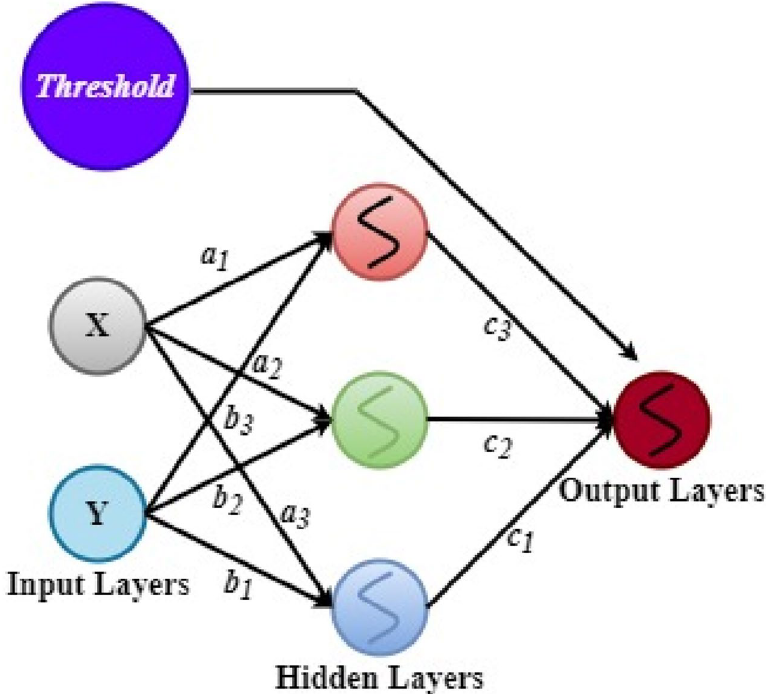
Figure 4. Artificial neural network